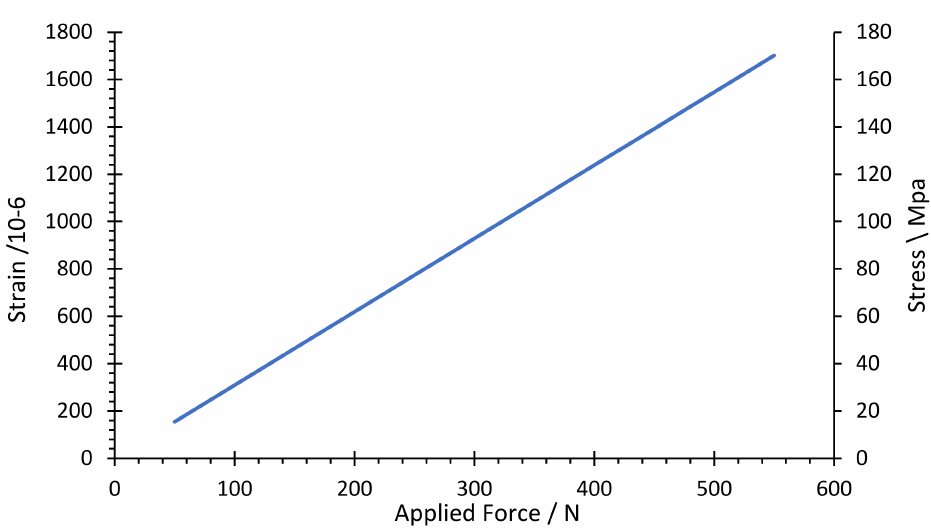
Figure 13. Stress and strain curve versus applied torque for the optimized